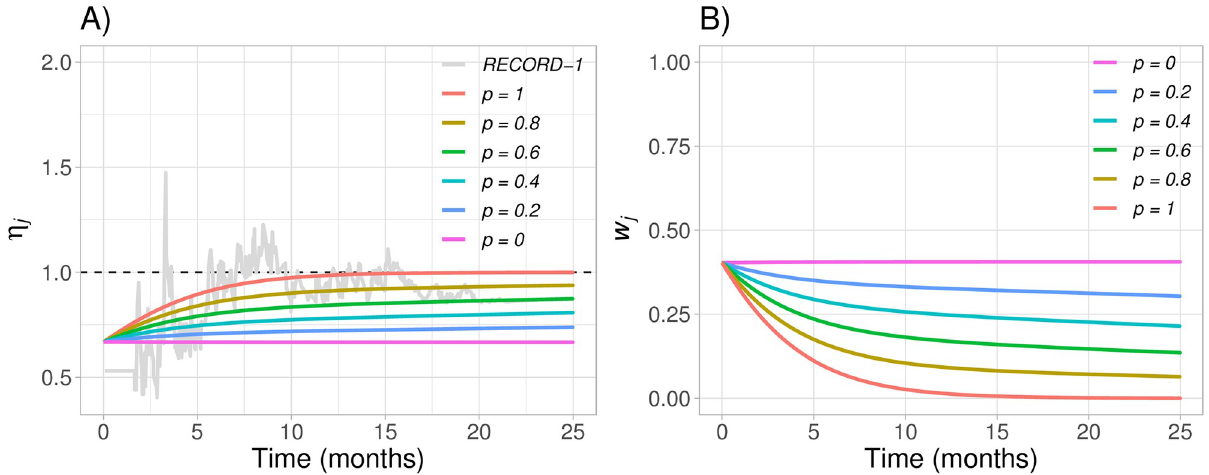
Fig 5. Hazard ratio from the RECORD-1 trial and hazard ratio functions obtained with the model based on exponential progression switching (plot A), and corresponding weights functions from Eq (6) (plot B), for p = (0, 0.2, 0.4, 0.6, 0.8, 1), m OS weights using p = 0 are equivalent to those from the standard log-rank ( LR )